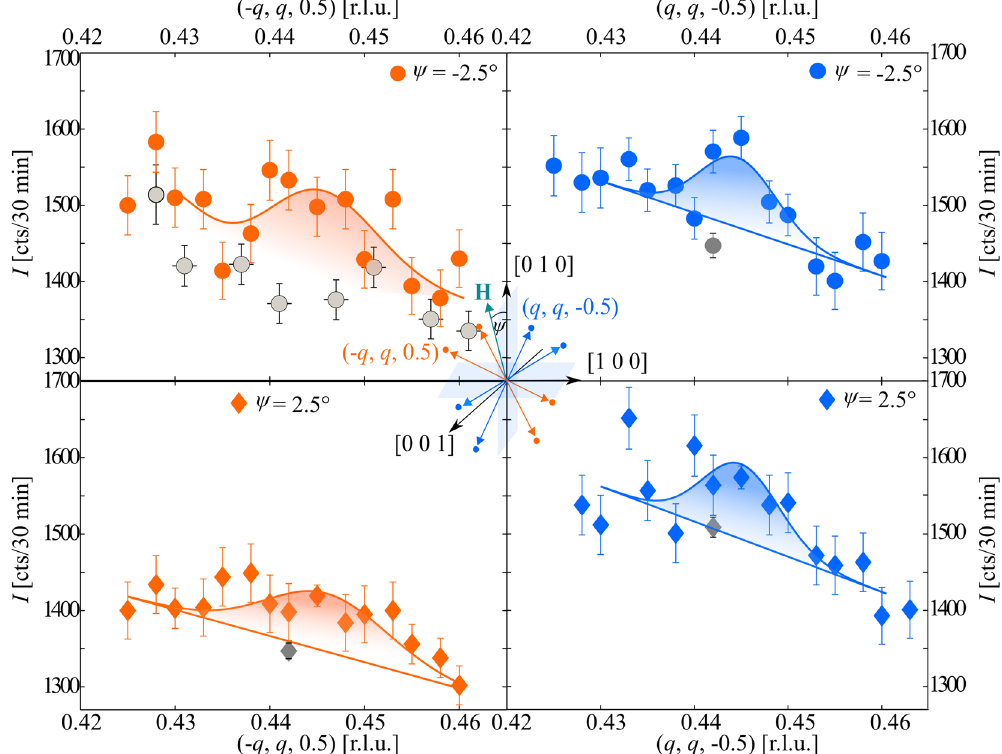
Figure 3. Switching in the SDW-phase. Diffracted neutron intensity along the tetragonal plane of Q 2 in orange and Q 1 in blue, measured at μ 0 H = 2 T and T = 40 mK for ψ = ± 2.5°. Background in gray was measured at = 11.9 T. Solid lines represent Gaussian fits on a sloping μ 0 H